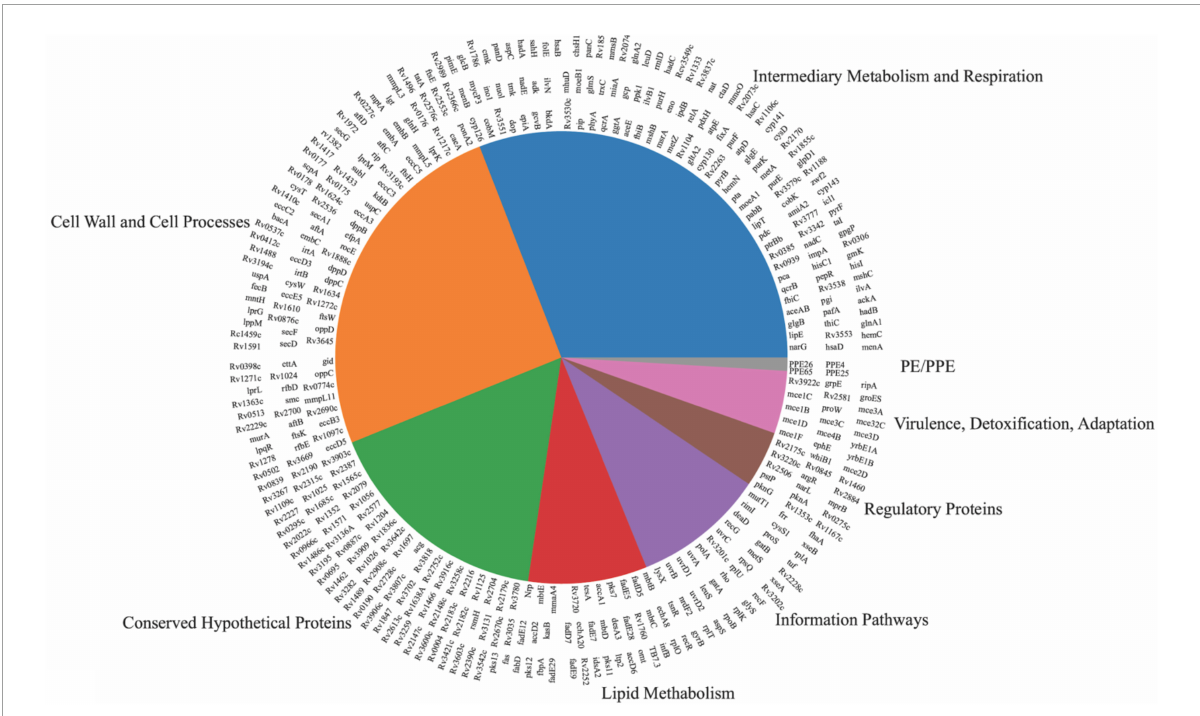
FIGURE3 Distribution of in vivo essential and growth-defect genes over eight functional categories. Genes mentioned on top of each pie are from that specific category.